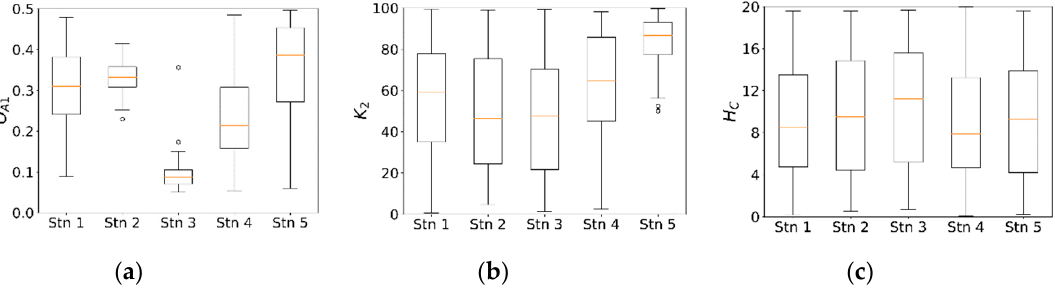
Figure 11. Ranges of two most sensitive parameters (( a ) and ( b )) and one least sensitive parameter ( c ) developed from 100 different initial parameters using the dynamically dimensioned search (DDS) algorithm.